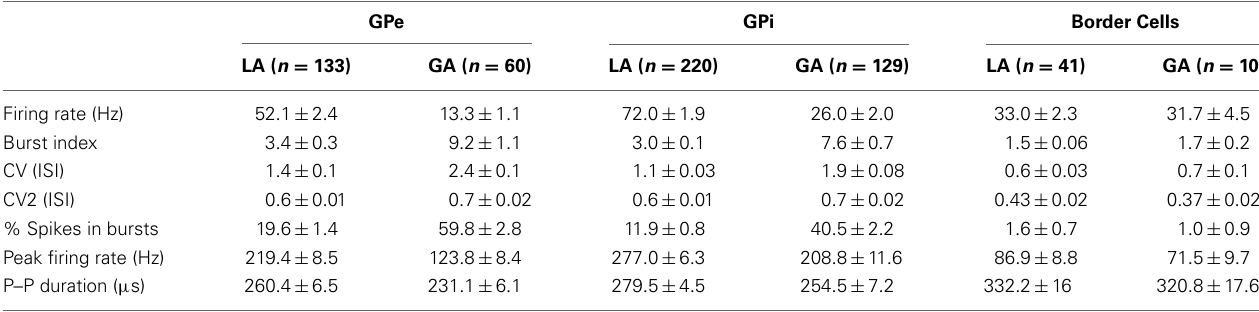
Table 2 | Electrophysiological properties of GP neurons in patients with